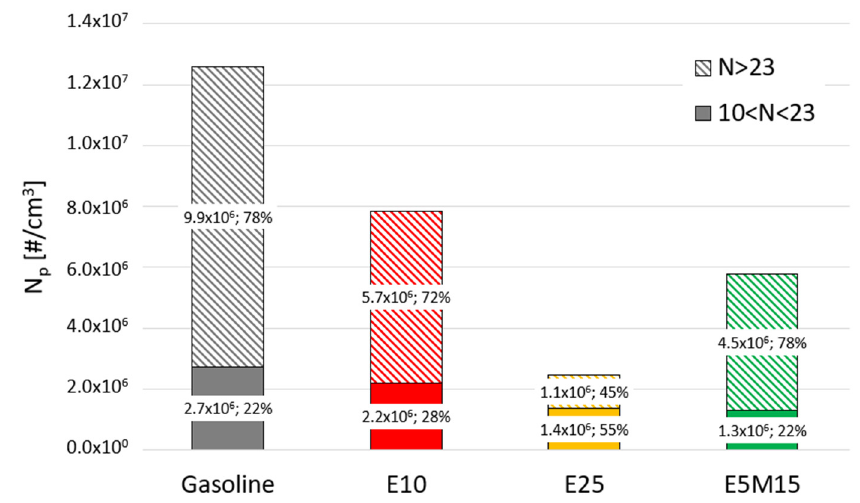
Figure 10. Total particle number emitted from gasoline, E10, E25 and E5M15.